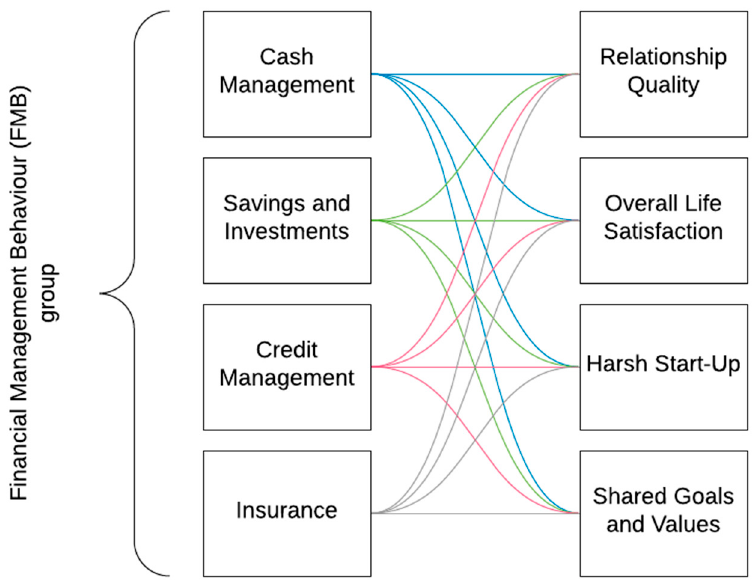
Figure 1. Analytical model (developed by the authors).